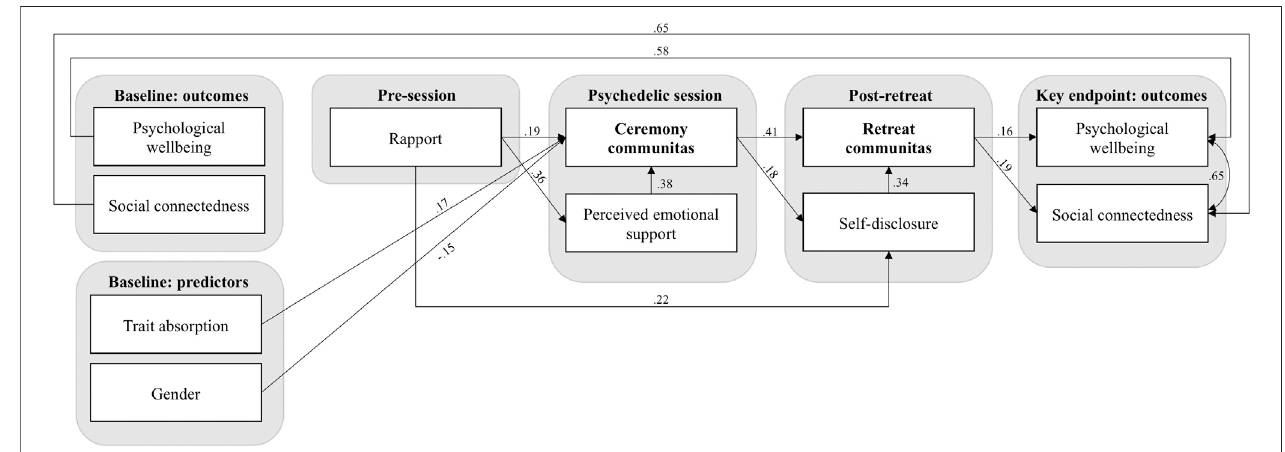
FIGURE 6 | Final path model showing the structure of psychosocial mechanisms of psychedelic ceremonies, measured across 5 time points. Standardized coef fi cients are shown for signi fi cant ( p < 0.05) regression paths.